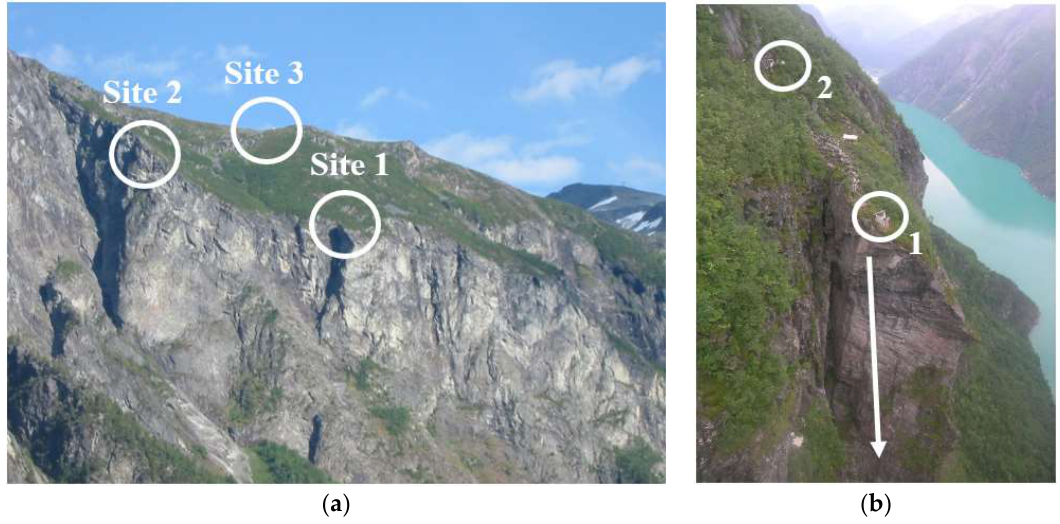
Figure 3. ( a ) Hegguraksla Mountain viewed from Fjørå where the radar is located. The three areas (Sites 1–3) are marked with white circles. ( b ) is a close-up picture of Site 1, showing the vertical fault and the location of reflector 1 and 2. Reflector 1 is the main reflector, and 2 is the reference reflector. The white arrow indicates the anticipated motional direction of the block.